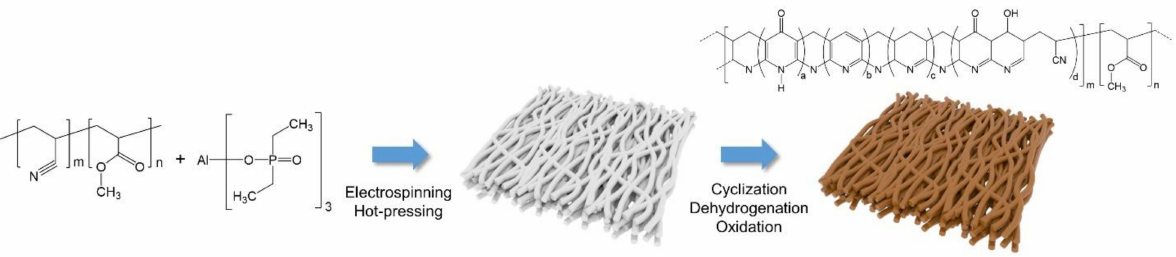
Scheme 1. Schematic illustration of the fabrication of the PAN/ADEP composite membranes by